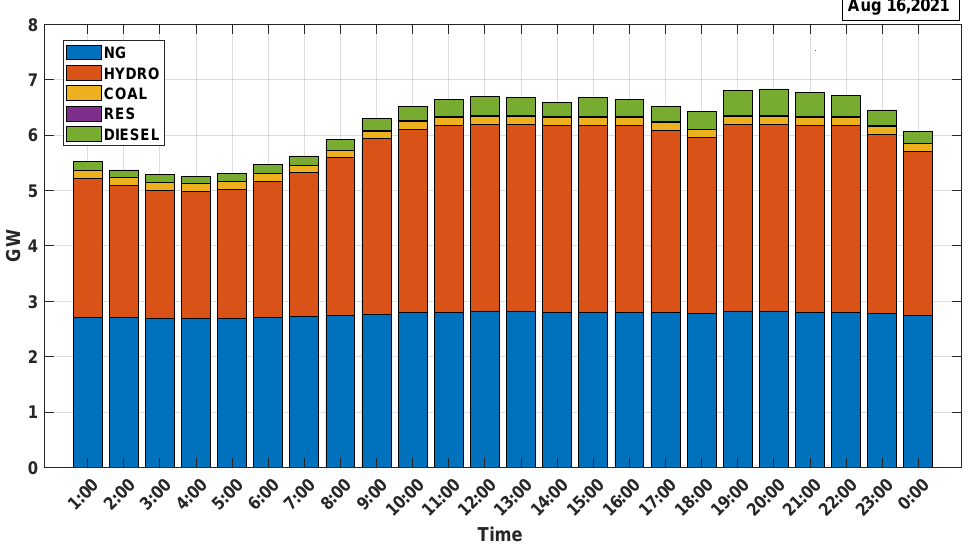
Figure 21. Contribution added to the dispatch by type of technology—stage 3.